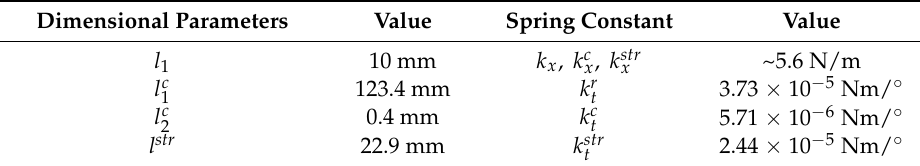
Table 2. Dimensional parameters and spring constants of three types of springs with the same spring constant along the x -axis. Dimensional